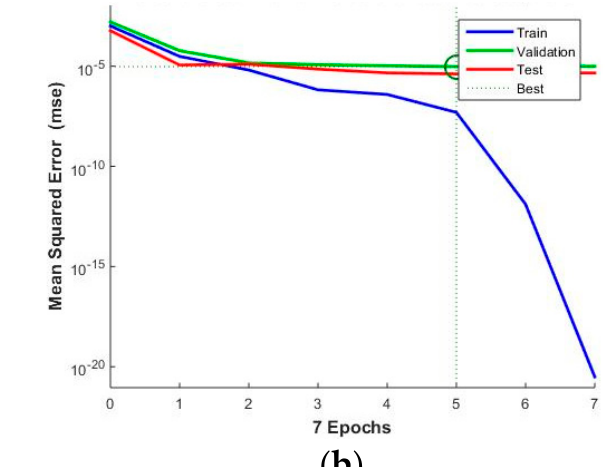
that the best performance was obtained by the NN4 and NN2 networks for determining all three parameters and expansion, respectively. The NN1 network obtained the weakest performance for determining the thin-film thickness parameter.